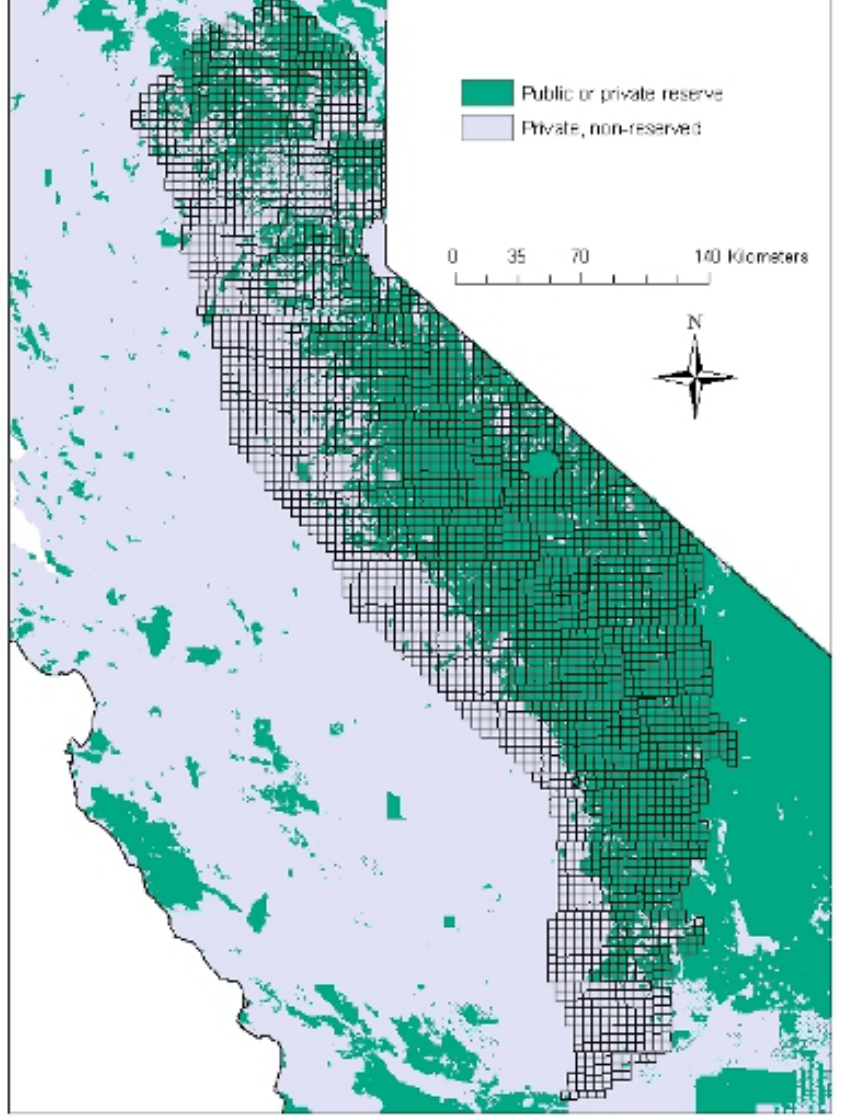
Fig. 4. Township quadrants used as planning sites in the Sierra Nevada bioregion, and the distribution of reserved vs. nonreserved